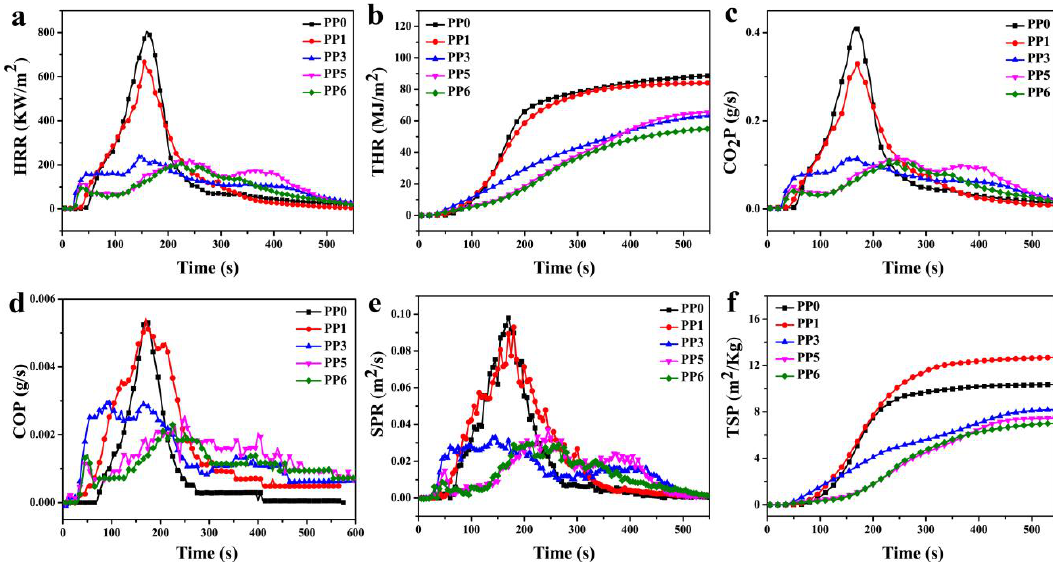
Figure 4. HRR ( a ), THR ( b ), CO 2 P ( c ), COP ( d ), SPR ( e ) and TSP ( f ) curves of samples during the combustion in CCT. Table 3. Data of the pure PP and its flame-retardant composites during cone calorimeter combustion. Sample